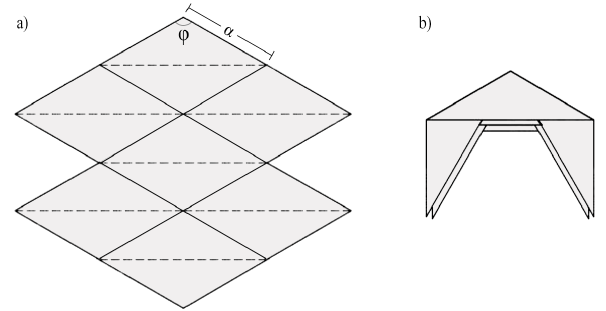
Figure 9: Yoshimura CP: a) unfolded and b) fully folded configura- tions